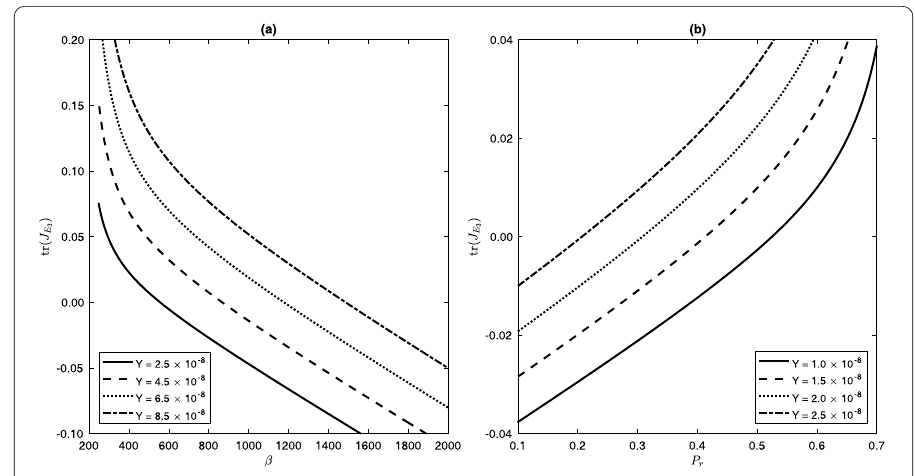
Figure 8 The trace of the Jacobian matrix evaluated at the EE tr J ( E 3 ) given by (63) as a function of the contact rate β for P r = 0.15 (part ( a )) and as a function P r for β = 600 per year (part ( b )) and for different values of Y , while keeping the parameters q 0 , μ , α and γ as in Table 1.